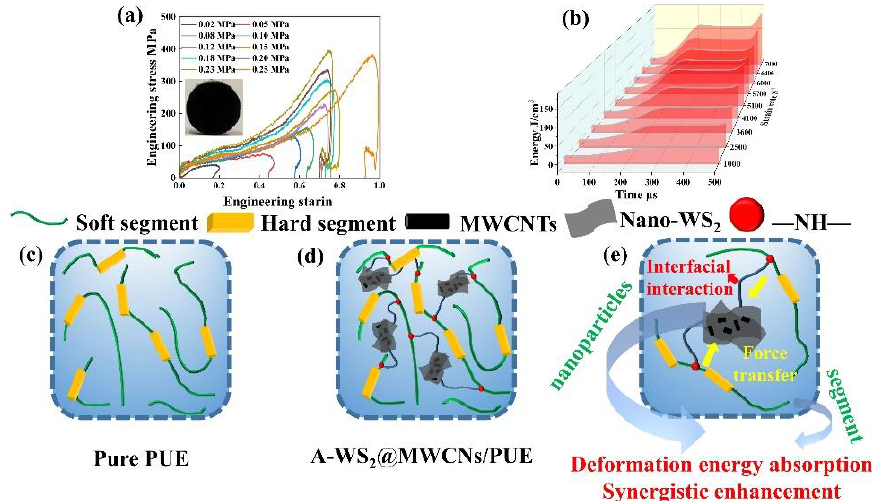
Figure 6. ( a ) Stress-strain curve of 1.5%A-WS 2 @MWCNTs/PUE under 10 continuous impacts, ( b ) 1.5%A-WS 2 @MWCNTs/PUE energy absorption platform under 10 continuous impacts, ( c , d ) schematic diagram of pure PUE and A-WS 2 @MWCNTs/PUE internal chain segments, and ( e ) schematic diagram of A-WS 2 @MWCNTs-enhanced PUE impact resistance.